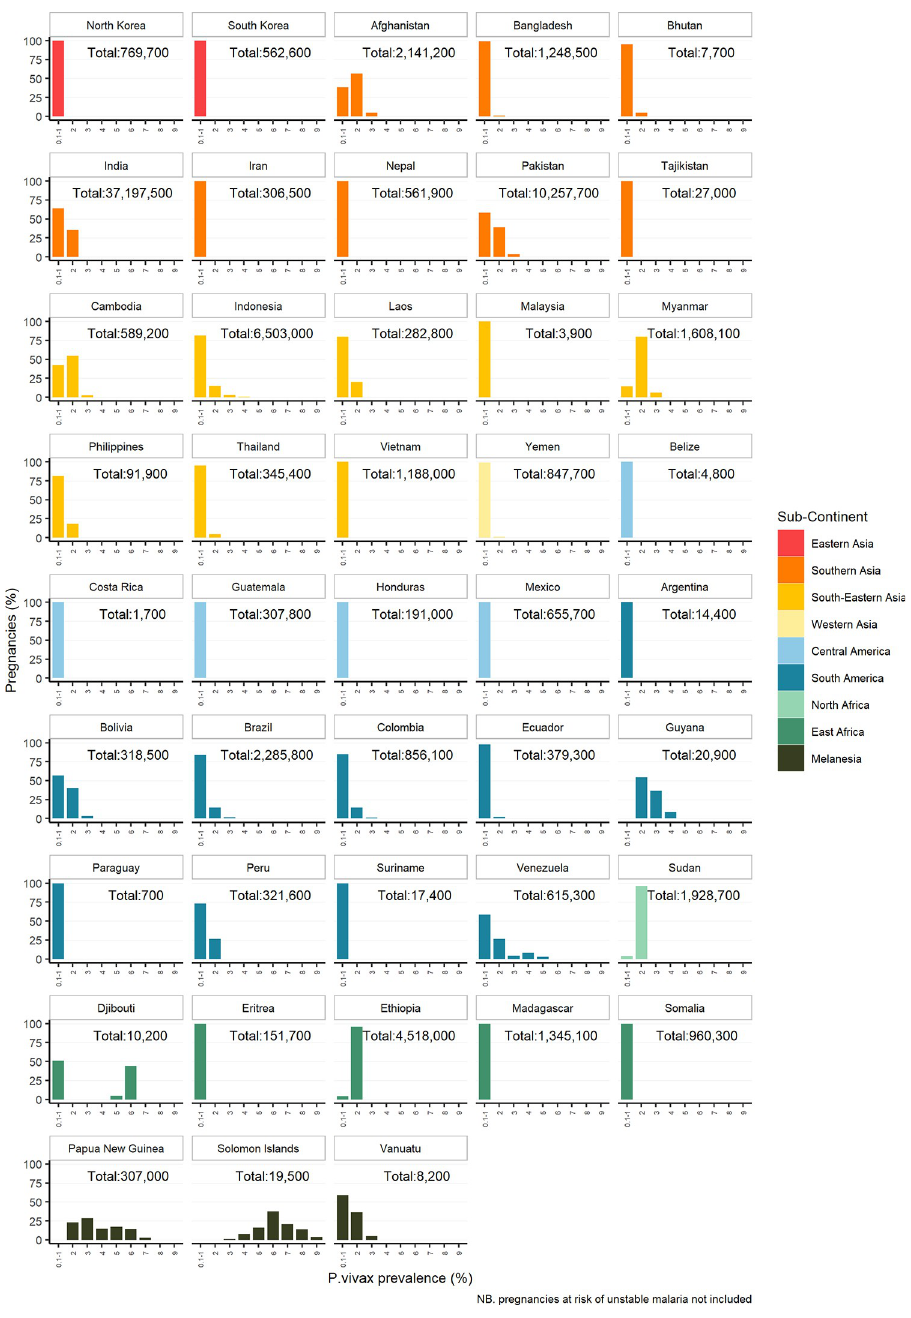
Fig 2. Proportion and total number of pregnancies at risk of stable Plasmodium vivax in 2020 in countries where > 10% of total at-risk pregnancies are at-risk of stable transmission.